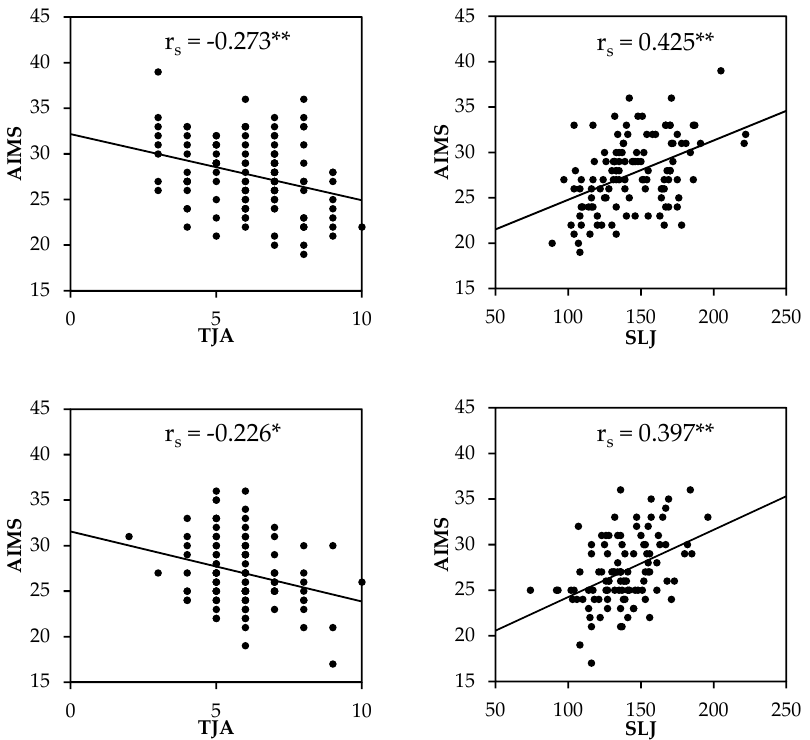
Figure 1. Associations between athletic motor skill competencies via the Athlete Introductory Movement Screen (AIMS), tuck jump assessment (TJA), and standing long jump (SLJ) performance in boys (above) and girls (below). ** Correlation is significant at the p < 0.01 level. * Correlation significant at the p < 0.05 level.